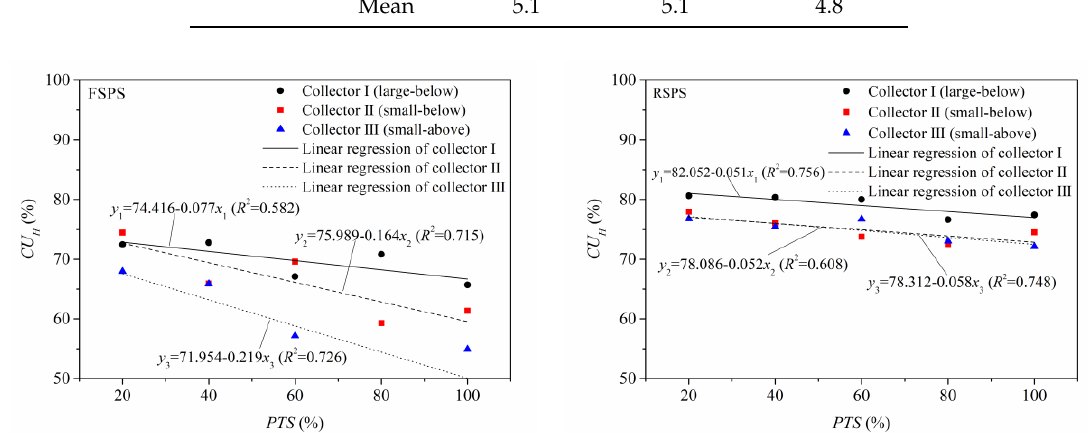
Figure 8. Effects of collector size and setting height on the water application uniformities produced by the two sprinkler types at the five different travel speeds: ( a ) FSPS; ( b ) RSPS. Note: subscripts (1,